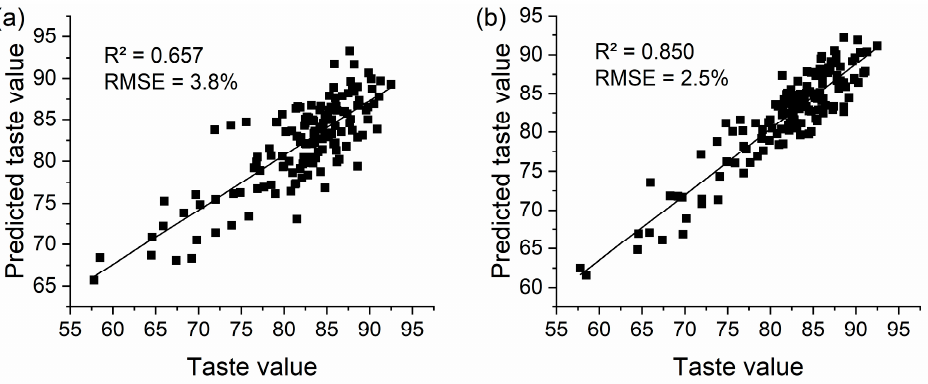
Figure 5. The eating quality model of hybrid indica rice using physicochemical indicators ( a ), and